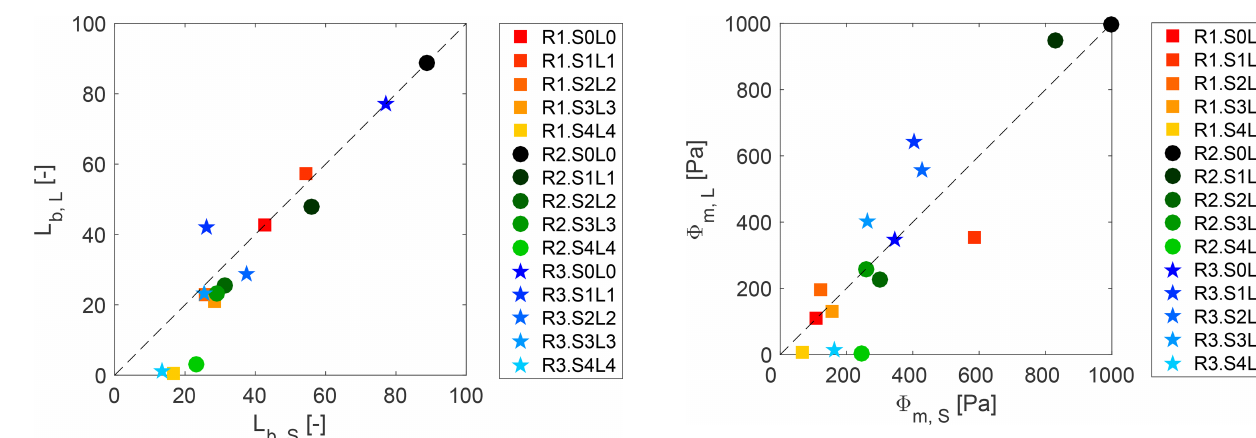
Figure 10. Comparison of the length of the body ( L b ) between tests with progressively reduced lock length and with lock slope. The dashed line is the identity line.